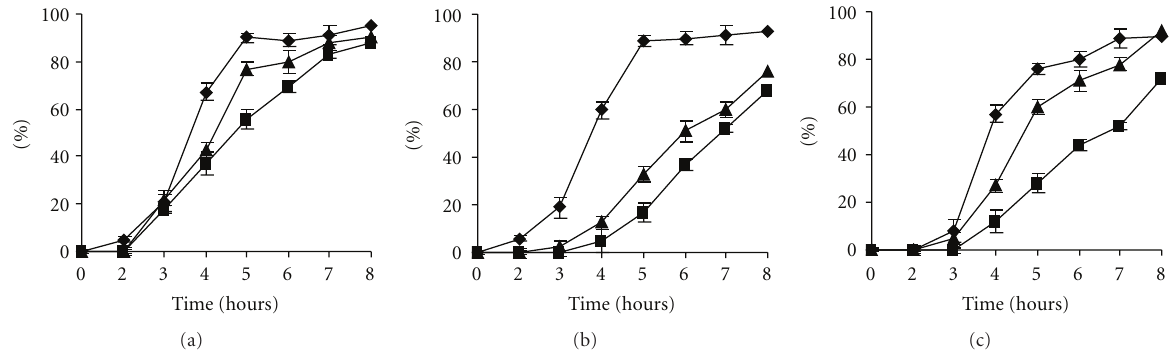
Figure 6: Germination and appressorium formation of the wild type (a), Cgpkac1 (b), and Cgpkac2 mutants (c) of C. gloeosporioides . Germination ( (cid:2) ), hooking ( (cid:3) ), and appressorium formation ( (cid:4) ).